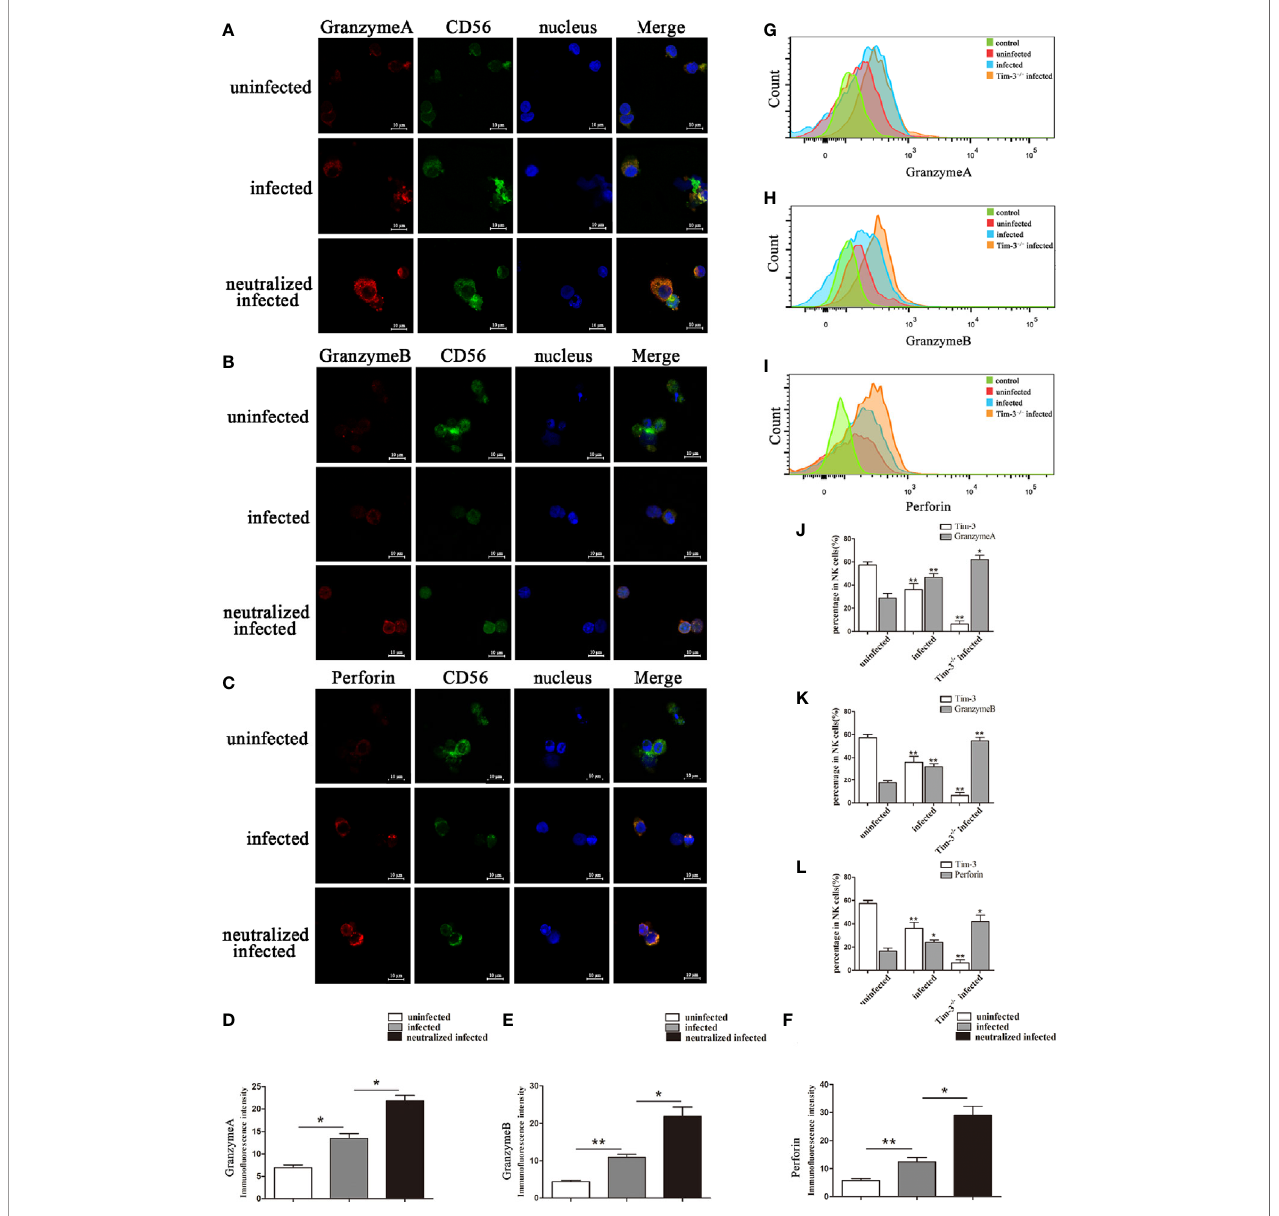
FIGURE 5 | Representative confocal micrographs of GranzymeA, GranzymeB and Perforin in human dNK cells and fl ow cytometry analysis of mice dNK cells. (A-F) Representative immuno fl uorescent photographs and immuno fl uorescent intensity analysis of GranzymeA (red), CD56 (green), GranzymeB (red) and Perforin (red) expression in uninfected, infected, and anti-Tim-3 neutralized infected huamn dNK cells. Nuclei were blue and stained using 4 ’ , 6-diamidino-2-phenylindole. Scale bar, 10µm. (Means ± SD; N=6 human samples per group, * p < 0.05, ** p < 0.01, by unpaired t -test). (G-L) In uninfected, infected and Tim-3 -/- infected mice, dNK cells expression of GranzymeA (G, J) , GranzymeB (H, K) and Perforin (I, L) levels were analyzed by fl ow cytometry and compared by unpaired t -test. (Means ± SD; N=8 mice per group, * p < 0.05, ** p < 0.01, by unpaired t